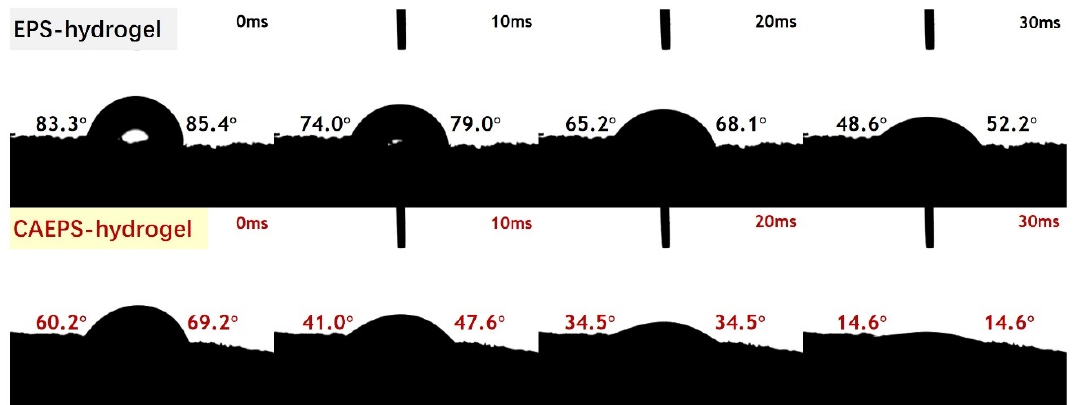
8 of 18 Figure 6. Pore size distribution of EPS- and CAEPS-hydrogels. 2.1.7. Surface Wettability of EPS-Xerogels and CAEPS-Xerogels The hydrophilia of the EPS- and CAEPS-xerogels were evaluated via contact angle